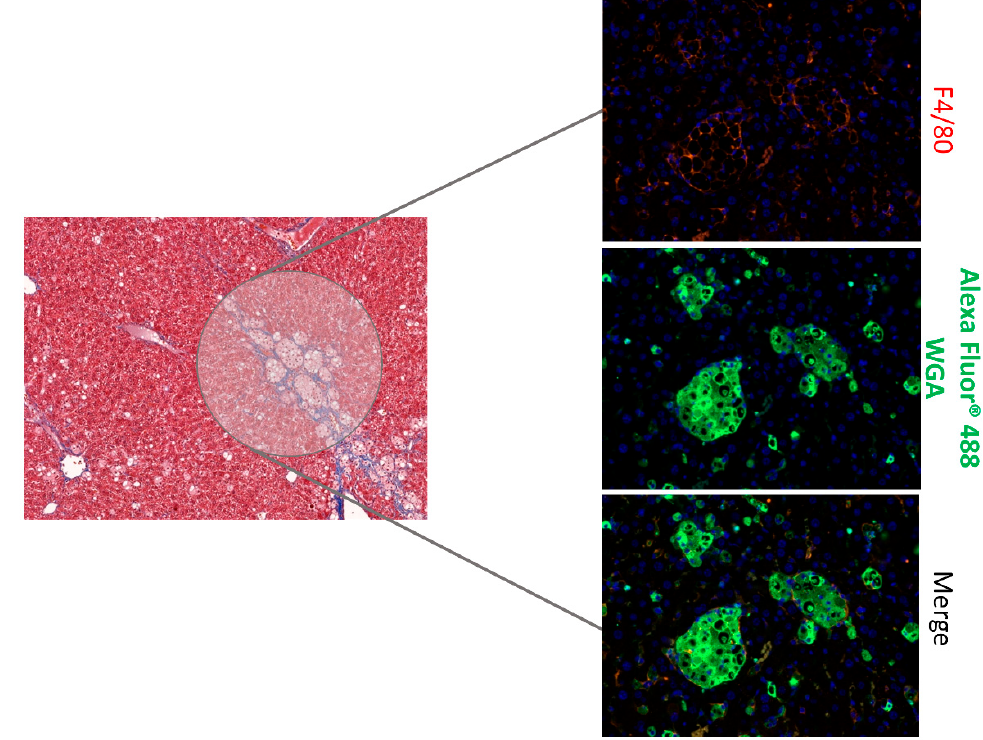
Figure 3. Effect of SST0001 on liver histology. Immunoflourescent staining of liver sections with macrophages marker (F4/80 antibody) and wheat germ agglutinin (WGA, a carbohydrate-binding lectin) showing granuloma-like structures.